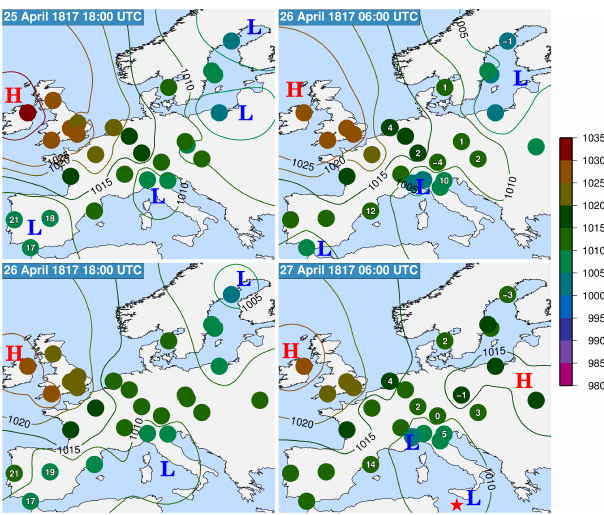
Figure 12. Similar to Fig. 9 but showing maps for 10–11 April 1817 at 12h interval. A star marks the position of the frigates Austria and Augusta on the morning of 11 April.